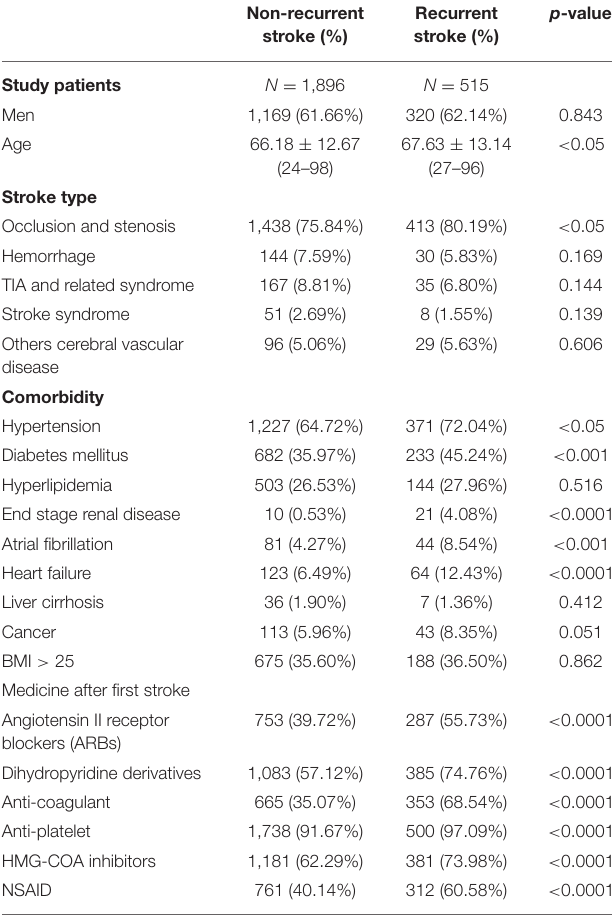
TABLE 1 | Clinical characteristics in 2,411 study